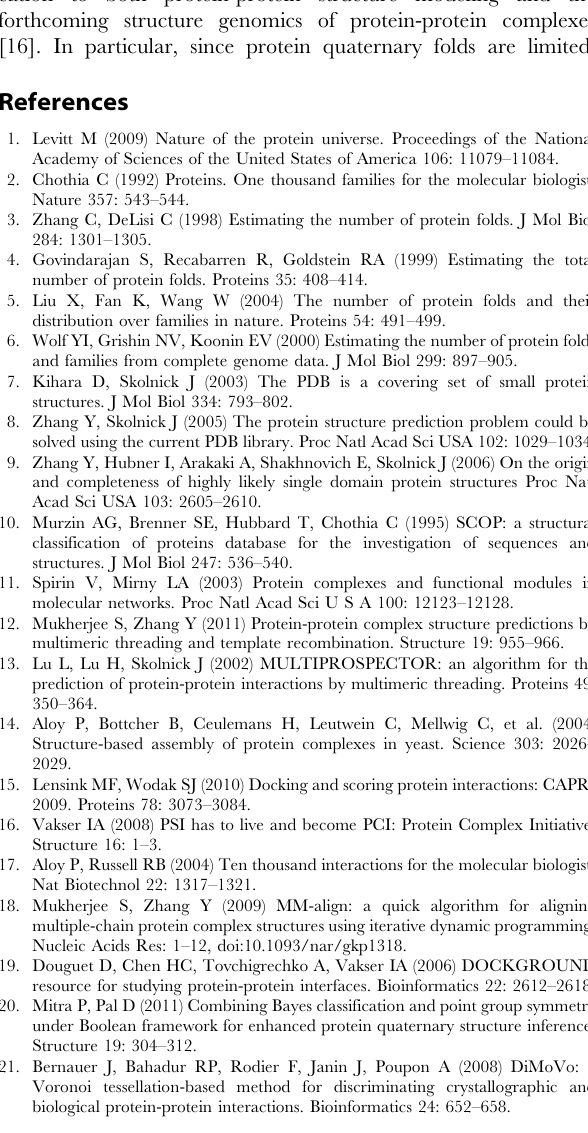
Figure S1 TM-score versus rTM-score of complex structures. (TIF) Figure S2 Illustrative examples to highlight difference between TM-score and rTM-score values. (TIF) Text S1 Correlation between TM-score and rTM-score.